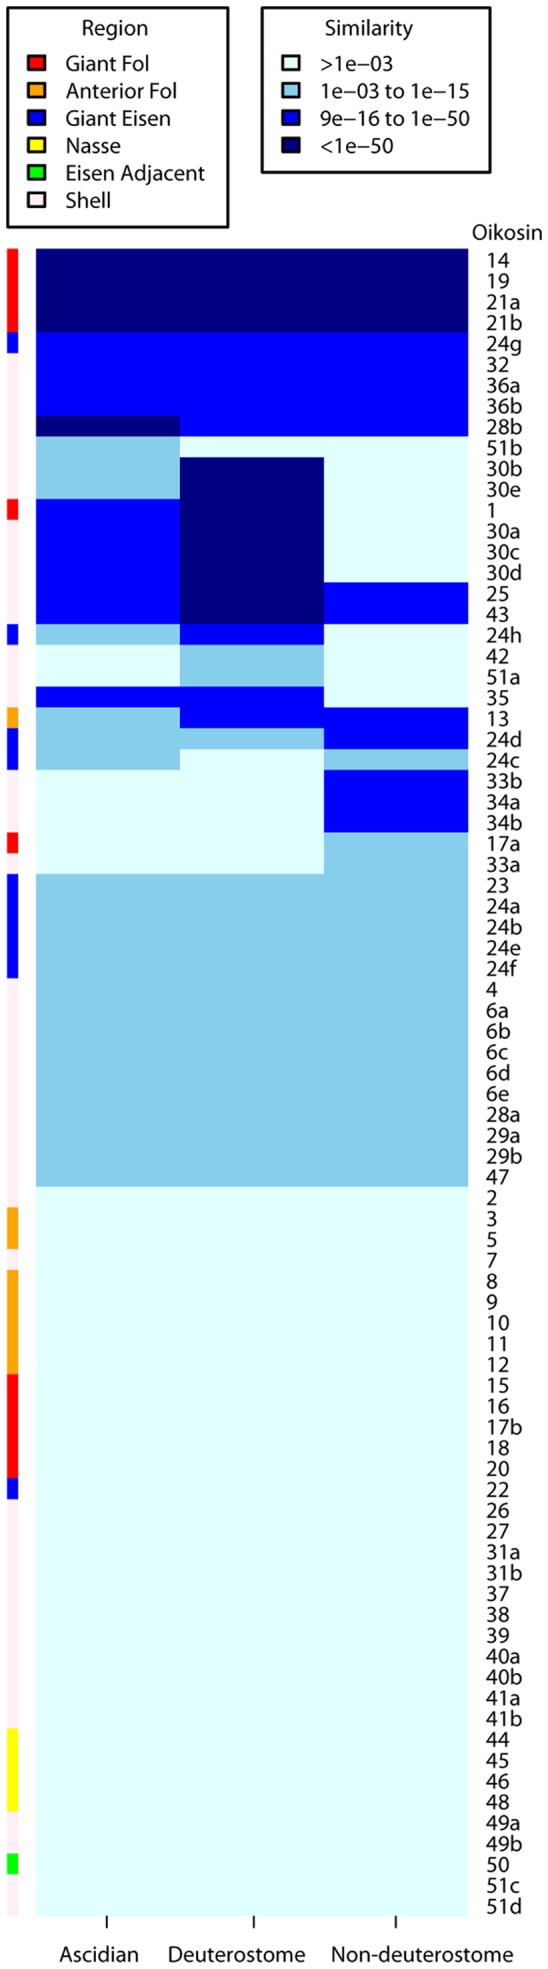
Similarity of oikosins to known proteins in ascidians, deuterostomes and non-deuterostomes.The location of expression of the corresponding oikosin genes is denoted at the left according to the “Region” legend above with color coding as in Fig. 1. Degree of similarity was binned in 4 categories as defined in the “Similarity” legend above based on e-values. More details concerning the homologies are given in Tables S4 and S5.